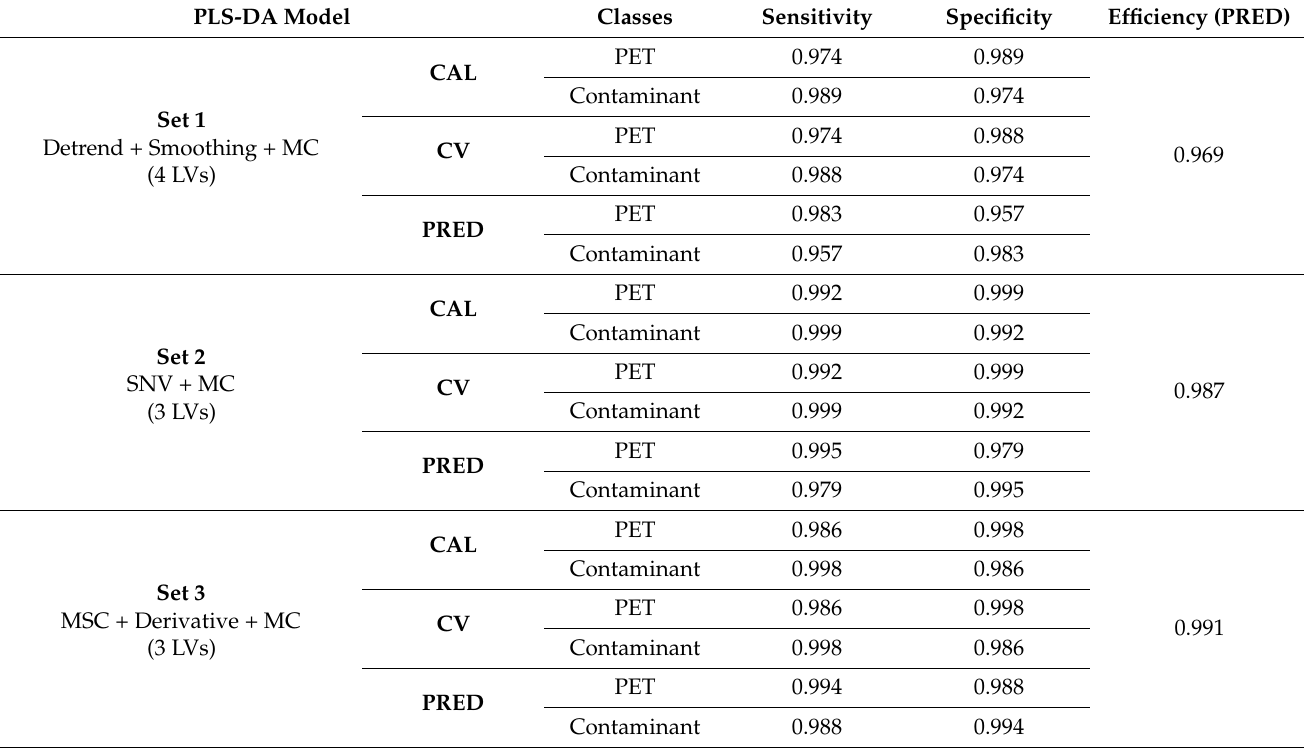
Table 4. PLS-DA classification performances in variables selection mode, for calibration (CAL), cross-validation (CV) and prediction (PRED) phases.